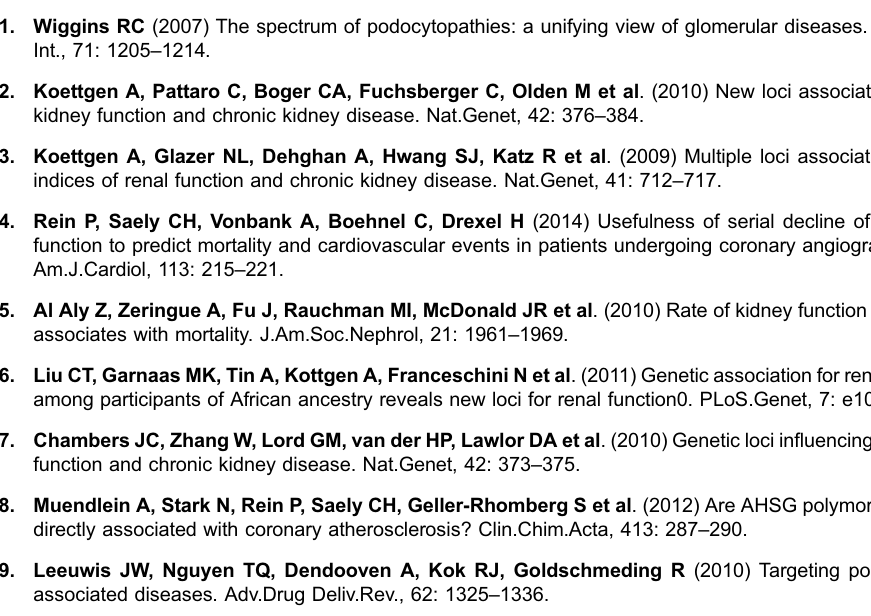
Figure S1. Q-Q plot showing the absence of inflation.